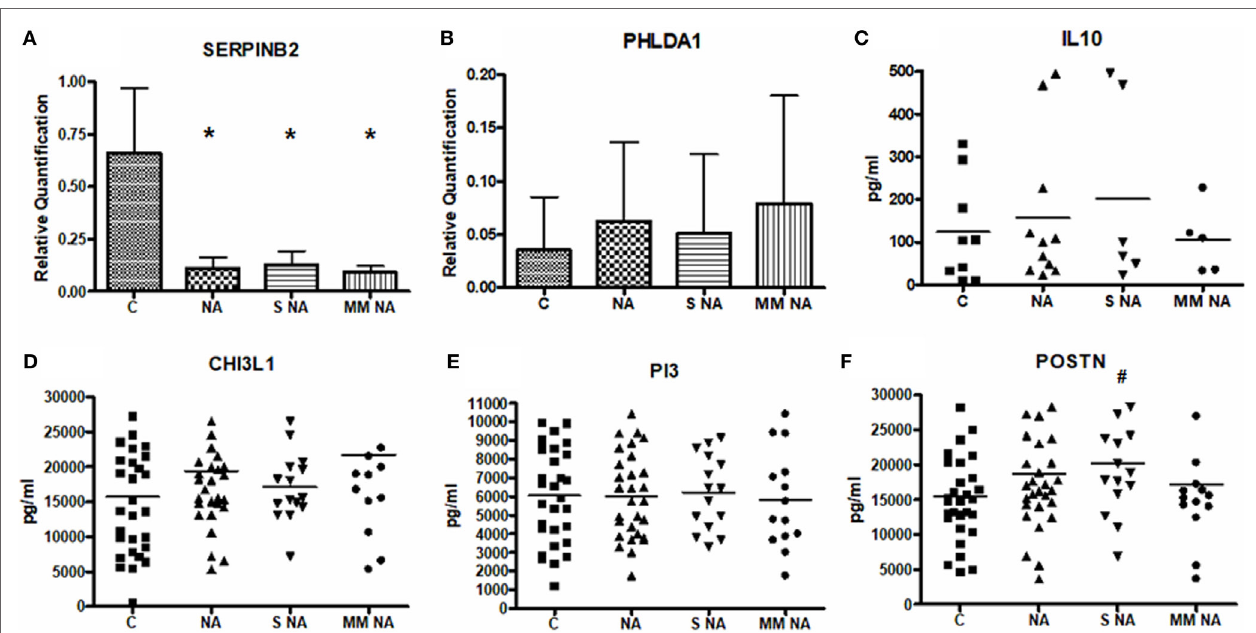
FigUre 1 | Mean levels of the protein expression. (a) Mean levels of SERPINB2. (B) Mean levels of PHLDA1. (c) Mean levels of IL10. (D) Mean levels of CHI3L1. (e) Mean levels of PI3. (F) Mean levels of POSTN. *Statistically significant comparison ( P < 0.0001) between the C and the group selected. #Statistically significant comparison ( P < 0.05) between the C and the group selected. Protein levels of SERPINB2 and PHLDA1 were measured by Western Blot in 6 C and 11 NA subjects (6 with severe asthma and 5 with moderate–mild diagnosis) and 8 C and 5 NA (3 severe and 2 moderate–mild patients), respectively. Densitometric analysis was done in individual blots (by the ImageQuant LAS 4000 software, as it is explained in Section “Materials and Methods”) using β -actin protein for normalization. IL-10, CHI3L1, PI3, and POSTN were quantified by ELISA in all the patients of the study population. Abbreviations: C, control group; NA, total nonallergic asthma group; S NA, group of subjects with severe asthma; MM NA, group of subjects with moderate–mild